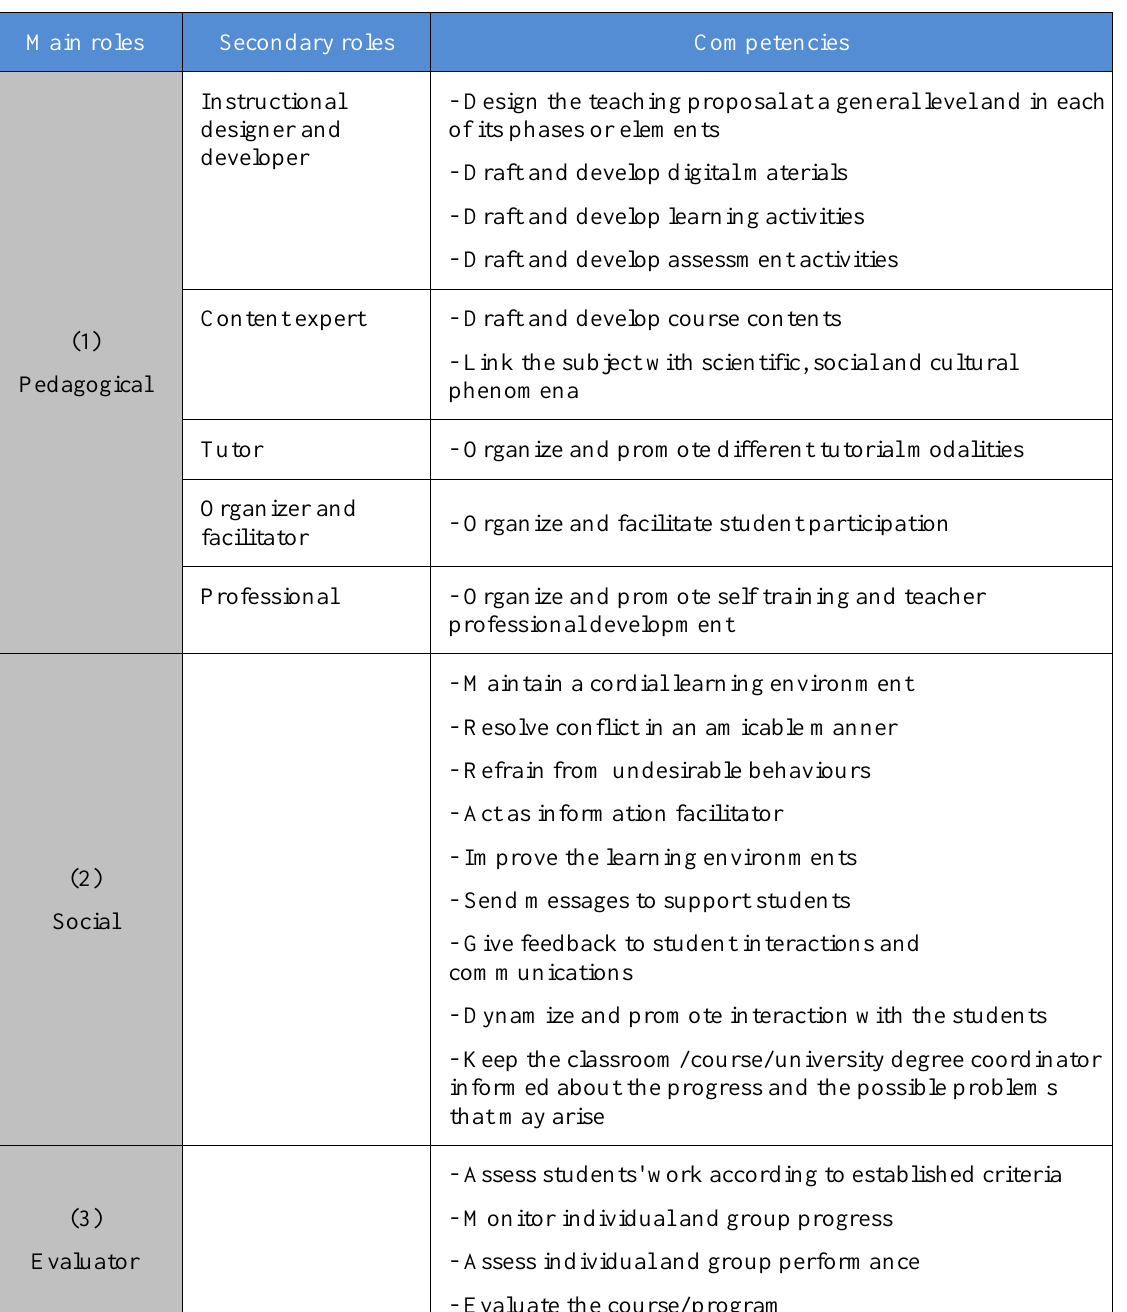
Table 2 Competencies Associated with the Roles of the Teachers Performing Online Main